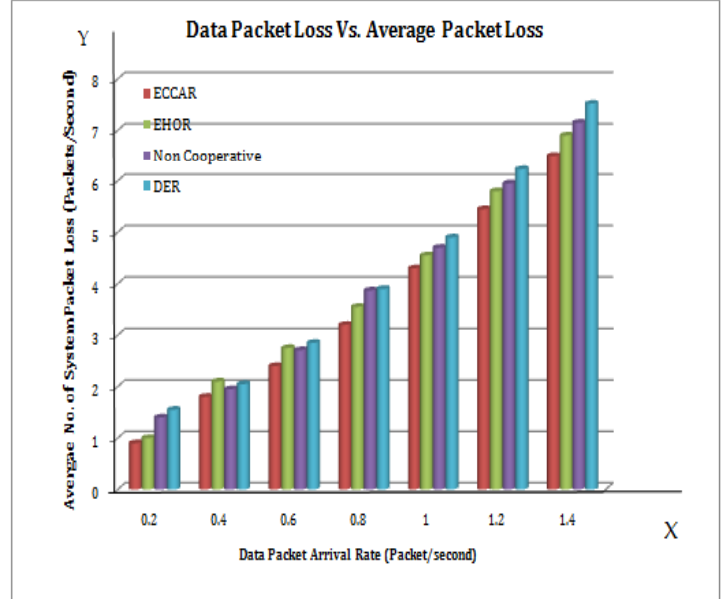
Figure 9. Data packet loss vs. Average packet loss.